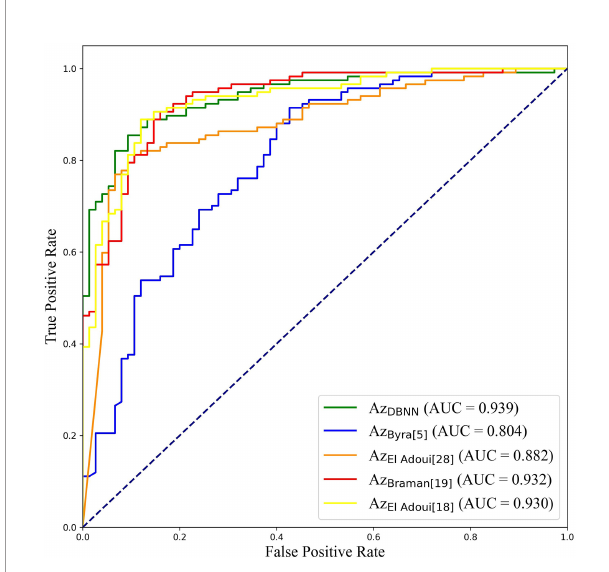
FIGURE 9 | ROC curves of DBNN and other NAC prediction